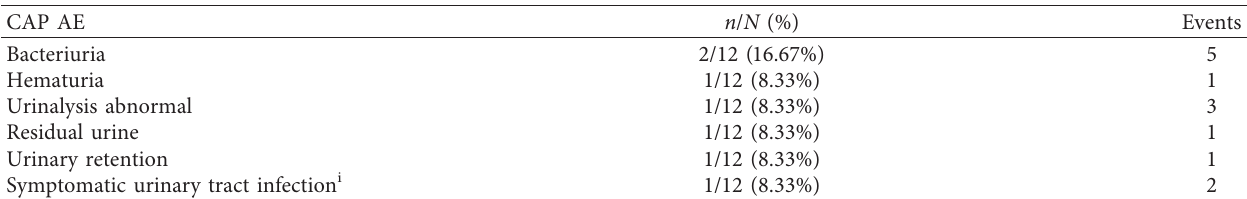
Table 8: Procedure and/or device-related adverse events for patients in the Continuing Access